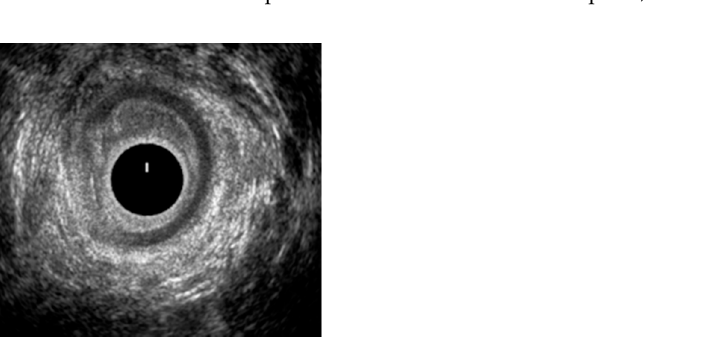
Figure 2. Laceration of the internal anal sphincter in the middle anal canal, between 7-11o’clock.